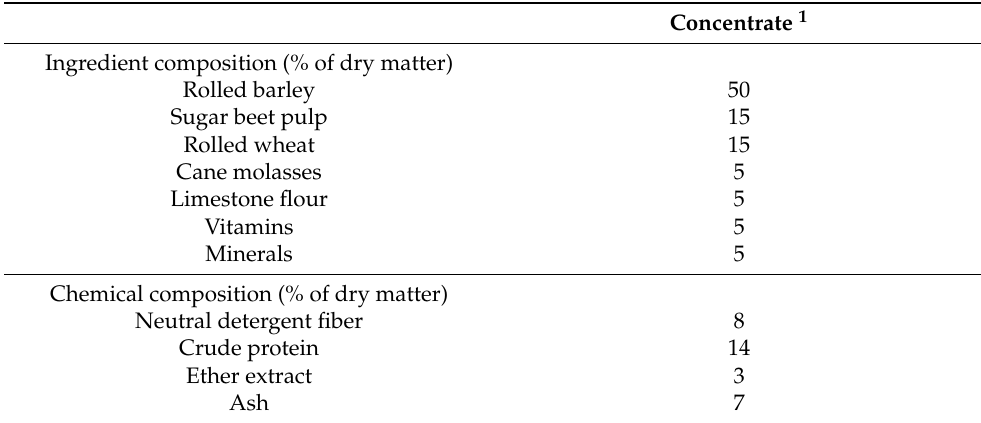
Table 1. Ingredients and declared chemical composition of the